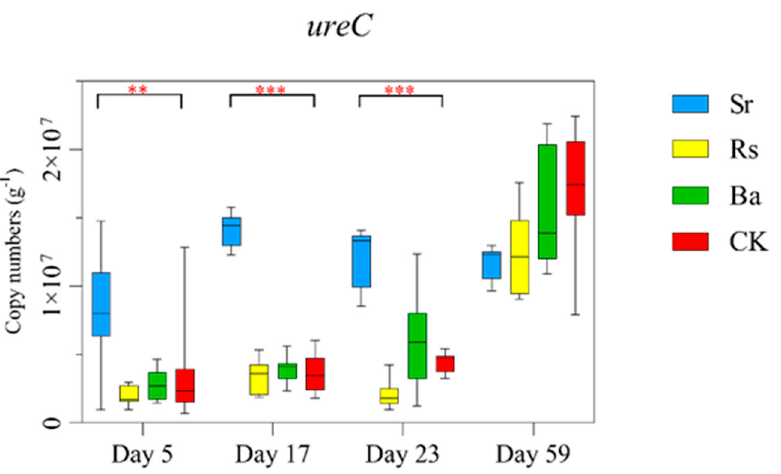
Figure 2. Differences in the abundance of gene ureC among treatments as based on Tukey’s HSD test, p values ( ** p < 0.01, *** p <